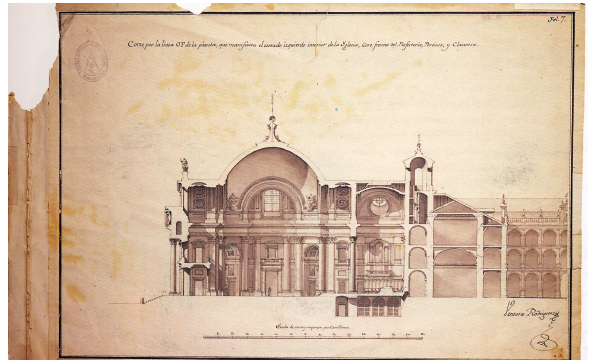
Figure 6. Proposal (1762) of San Ildefonso Chapel, Architect Ventura Rodríguez.